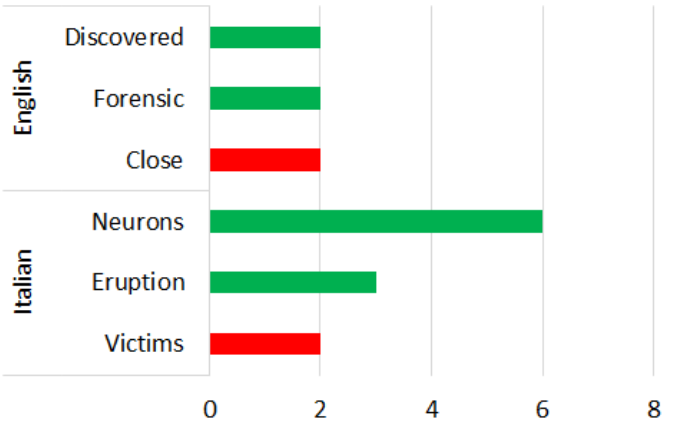
Figure 9. Percentage distribution of every primary emotion for English and Italian words during phase 2 of COVID-19 pandemic.